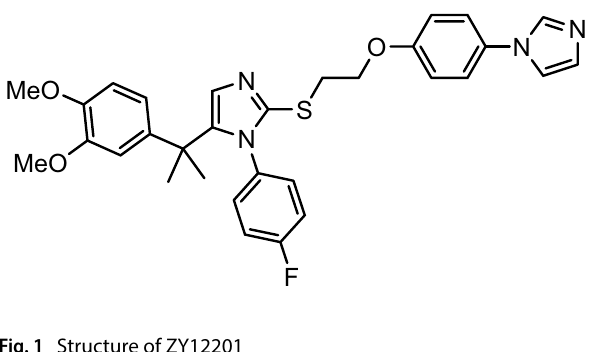
Fig. 1 Structure of ZY12201